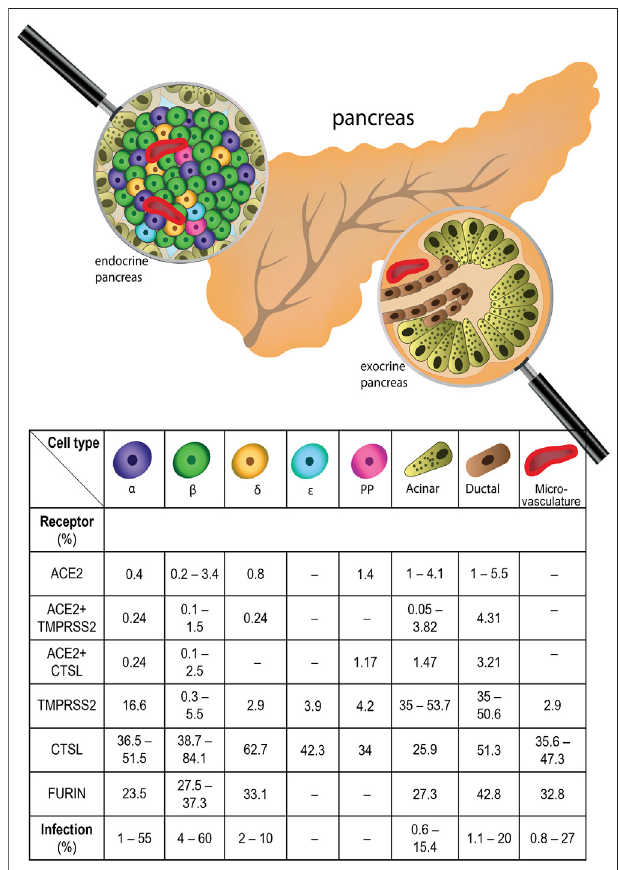
FIGURE 1 | Expression of SARS-CoV-2 receptors in human pancreas and frequency of SARS-CoV-2 infection in pancreatic cells. All major pancreatic cell types express SARS-CoV-2 receptors, with varying frequency. Thepercentages of cellsexpressing SARS-CoV-2receptor mRNAs, including ACE2 - Angiotensin converting enzyme 2, NRP1 - Neuropilin 1, TMPRSS2 - Transmembrane Serine Protease 2, CTSL - Cathepsin L in different types of pancreatic cells is shown. Additionally, the percentage of the cells infected by SARS-CoV-2 in certain pancreatic cell types is